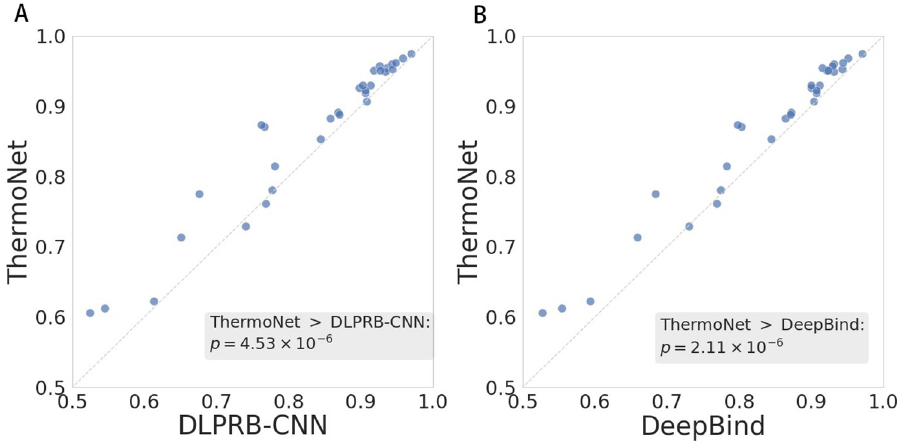
Fig 3. Pairwise comparisons of ThermoNet to (A) DLPRB-CNN and (B) DeepBind in in vivo binding. AUROC was used as the evaluation metric. Each point in the scatter plot represents one of 31 CLIP-seq experiments. The p - values were calculated using one-sided Wilcoxon singed rank